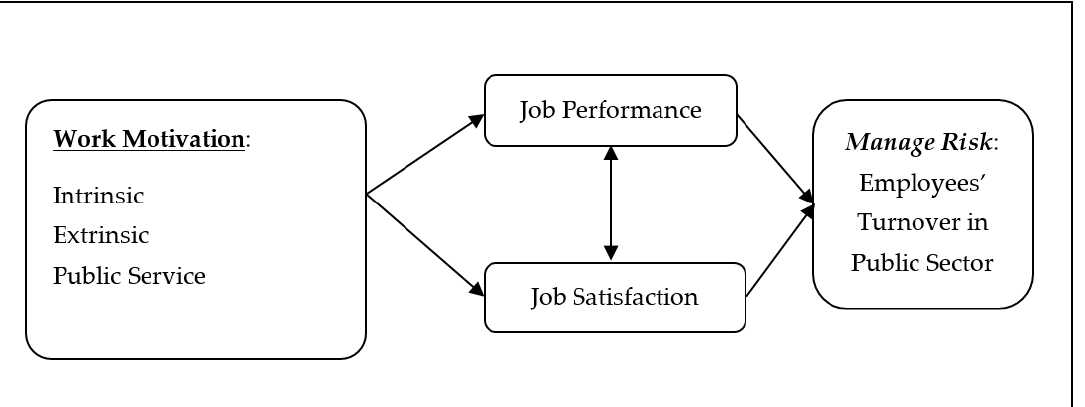
Figure 1. An explanatory risk management model depicting pathways of employee turnover in the public sector.